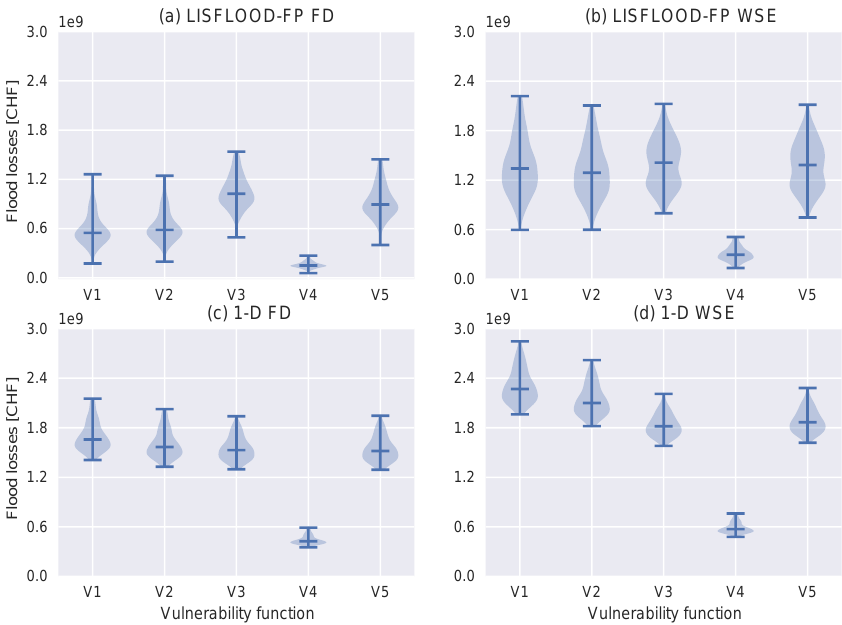
Figure 6. Flood losses aggregated at river basin level. The variation between the PMP scenarios is shown in the y axis, whereas the x axis shows the variability inherent to the vulnerability functions. The diagram in (a) shows flood losses that are calculated based on the flow depths as modelled by LISFLOOD-FP, the diagram in (b) shows the flood losses that are calculated based on the water surface elevation and the object-specific ground floor level. The flood losses estimated by the 1-D model are shown in (c) and (d) .